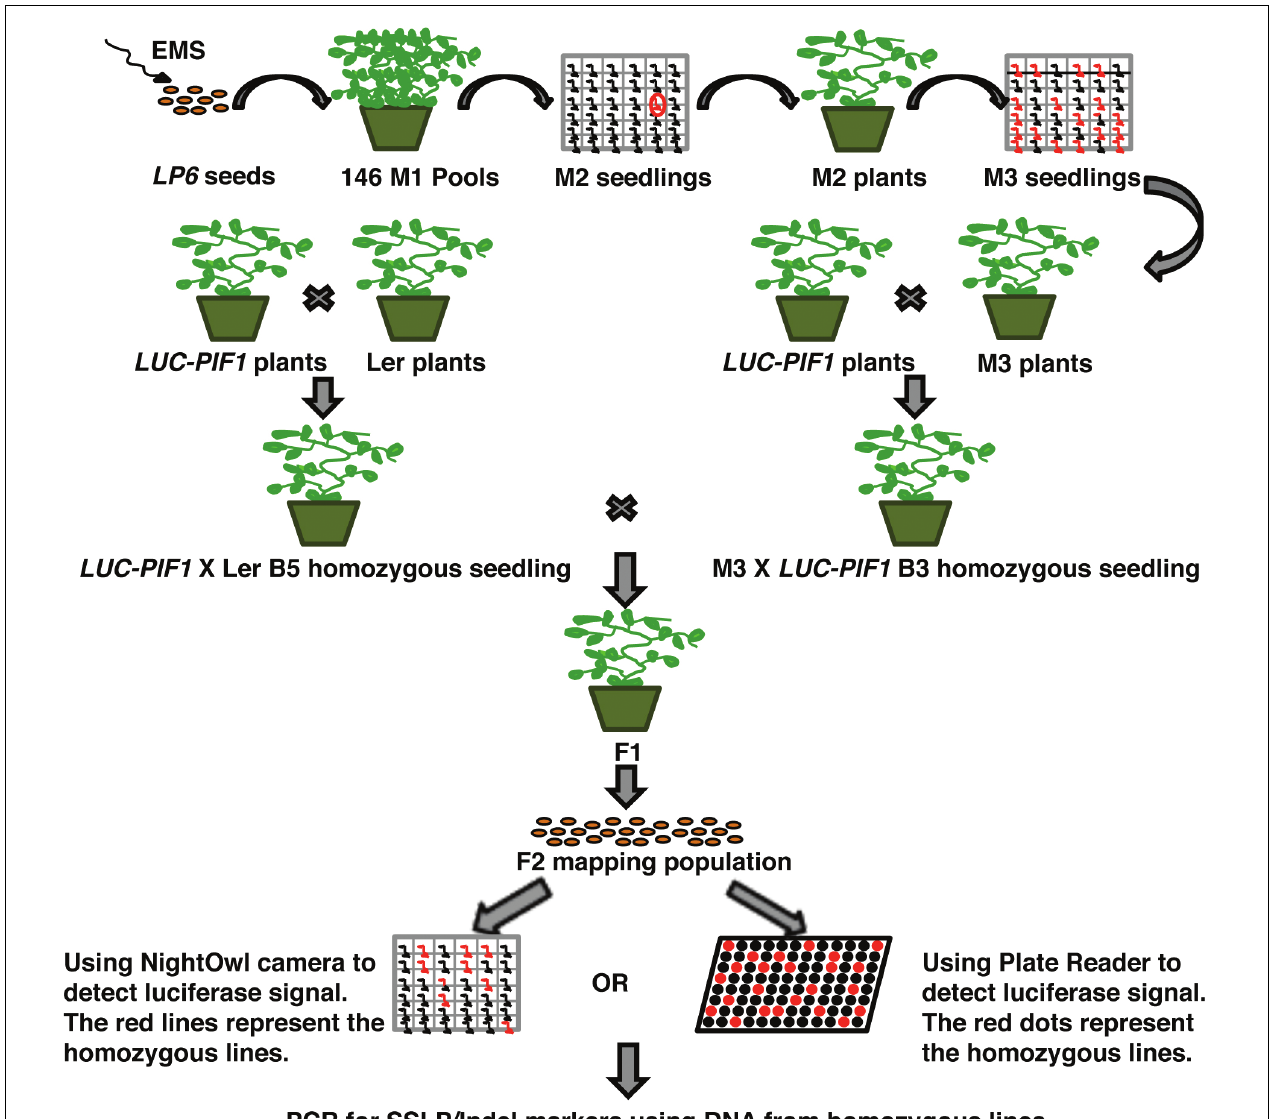
FIGURE 2 | Schematic diagram of the EMS mutant screening by luciferase imaging. Briefly, ∼ 40,000 LUC-PIF1 transgenic seeds were mutagenized with EMS, equally distributed into 162 pots for growth and harvested in 162 bulks. Hundred seeds from each bulk were tested by luciferase imaging as described (Chinnusamy et al., 2002). The seedlings showing stable luminescent signal after 15 min of white light exposure were selected and grown to maturity. Seedlings were back crossed with the parental line LUC-PIF1 three times. The homozygous lines after three times backcrosses were outcrossed with the homozygous LUC-PIF1 seedlings that have been introgressed into Ler by five times crossing. The F2 generation represents the mapping population used for rough mapping using SSLP/CAPS/Indel